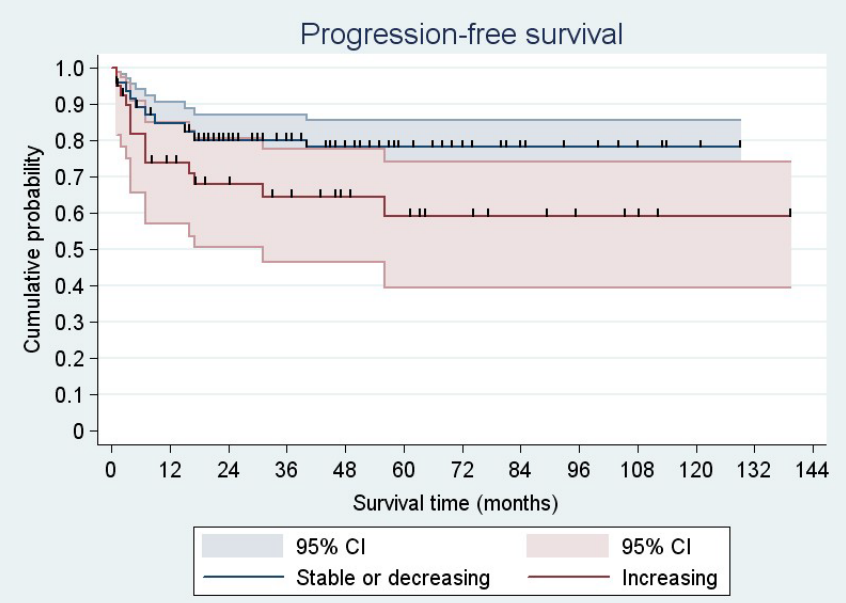
Kaplan-Meier analysis of progression-free survival after stratification for radiological progression prior to PC-RPLND. Stable or decreasing on imaging: progression-free survival at 5 years 78% (95% CI: 68–86%); Increasing on imaging: progression-